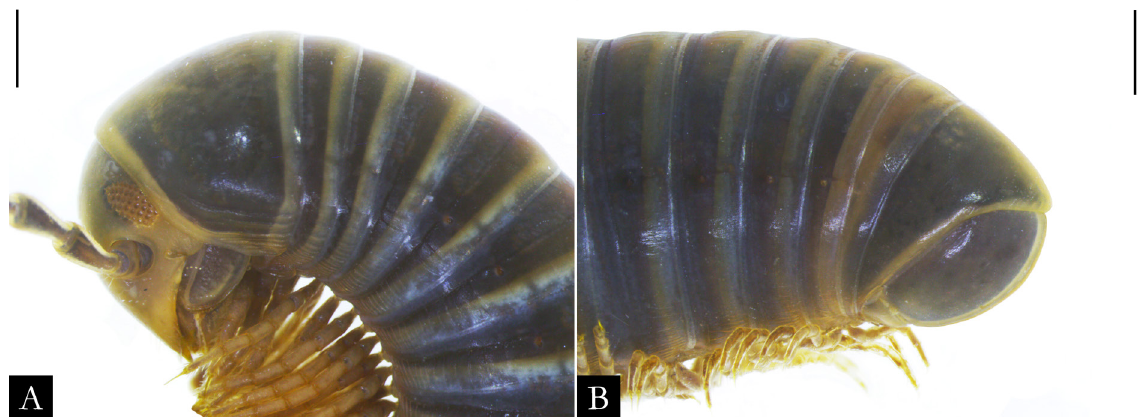
Fig. 109. Pseudonannolene paulista Brölemann, 1902, ♀ (IBSP 1915), in lateral view. A . Anterior region. B . Posterior region. Scale bars = 1